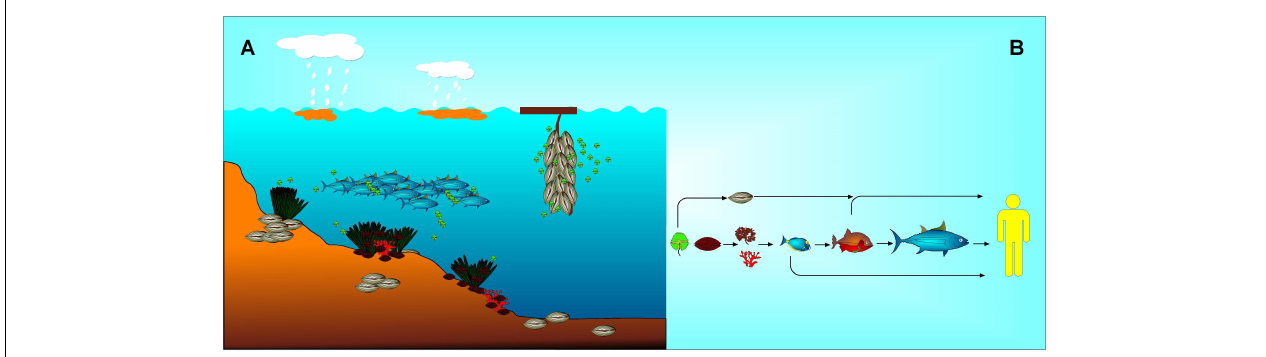
FIGURE 2 | Microalgal blooms may have different impacts on the environment and human health. (A) Some microalgae are ichthyotoxic (e.g., Pseudo-chattonella, Chrysochromulina ), causing massive fish kills in aquaculture sites or natural fish populations. High microalgae cell concentrations can aggregate at the water surface and form floating foams that decrease water bath quality and light availability for other aquatic organisms. In some cases, from the (floating or not) aggregates compounds causing respiratory irritation are aerosolized by wind and waves (as in the case of Karenia and Ostreopsis ). In general, when the blooms decay, bacterial decomposition of the high microalgal biomass can decrease oxygen availability to the other organisms in the ecosystems. Some planktonic microalgae (e.g., Alexandrium, Pseudo-nitzschia ) are ingested by filter feeders such as cultured or naturally growing shellfish. Toxic benthic microalgae grow attached to corals of macroalgae. (B) Biotoxins bioaccumulate and are transferred through the food webs causing seafood borne poisonings in human. PSP, DSP,and ASP can occur from consumption of contaminated shellfish, while different fish species can cause